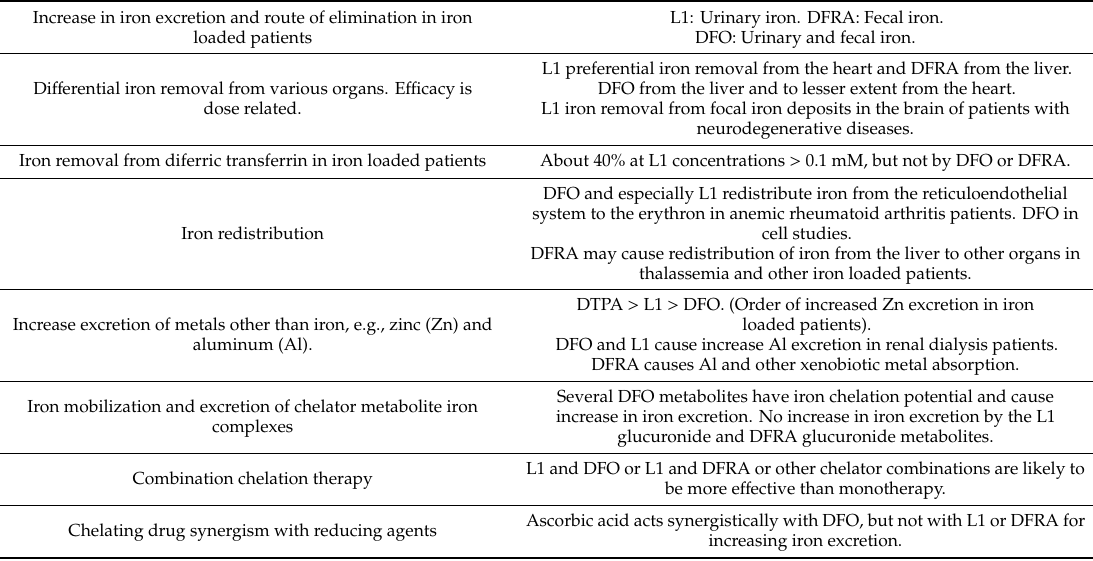
Table 5. Metabolic and other e ff ects of iron chelating drugs in